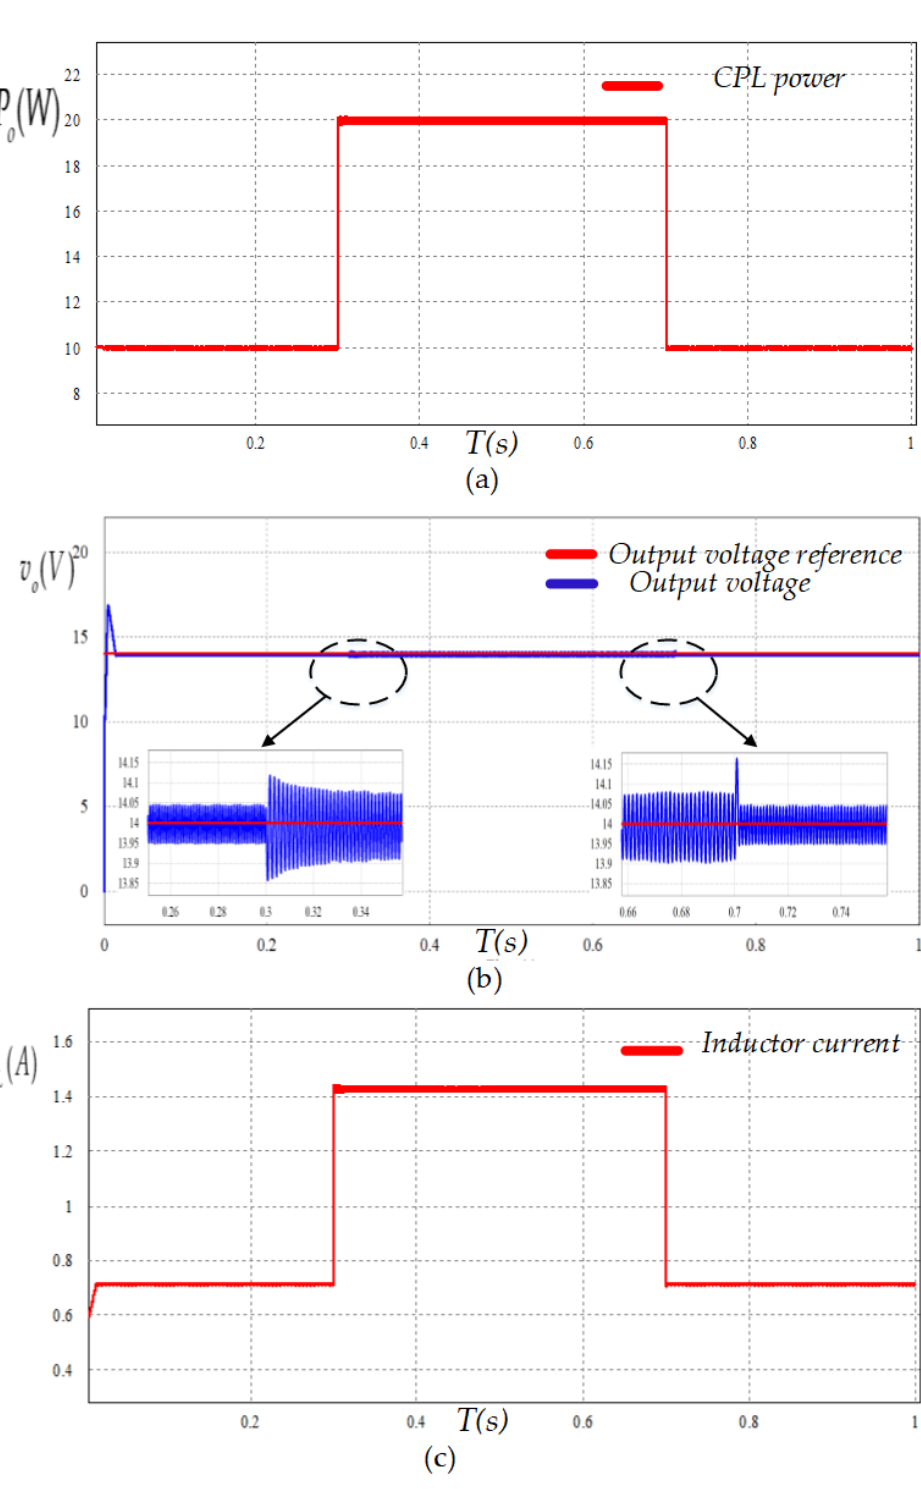
Figure 11. Response to variable power consumption of the CPL: ( a ) power demand variation test; ( b ) output voltage; and ( c ) output current.